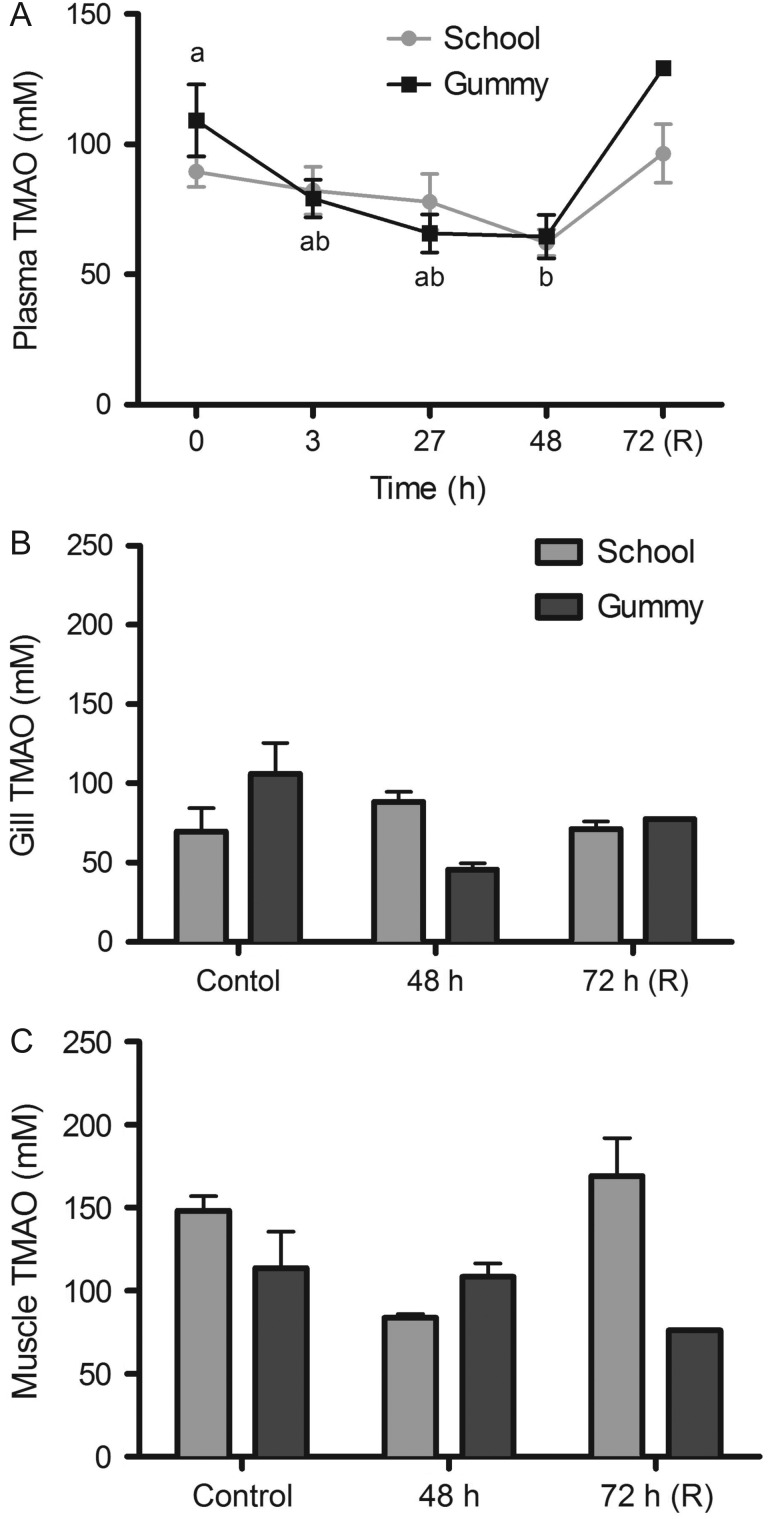
Trimethylamine N-oxide (TMAO) concentration (in millimoles
per litre; mean values ± SEM) in plasma
(A), gill (B) and white muscle (C) in
school sharks (G. galeus) and gummy sharks (M.
antarcticus) following exposure to 75% seawater.
Different letters indicate statistically significant differences over time
(P < 0.05; see Materials and
methods for species replication numbers). Recovery (R) data are not included
in the statistical analyses.